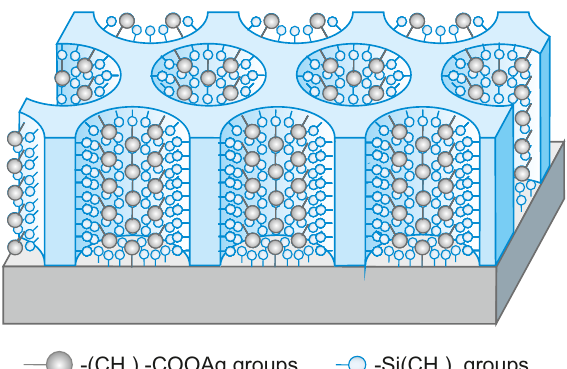
Figure 2. The scheme of a vertically aligned porous silica thin film containing silver ions anchored inside pores via propyl-carboxyl units.